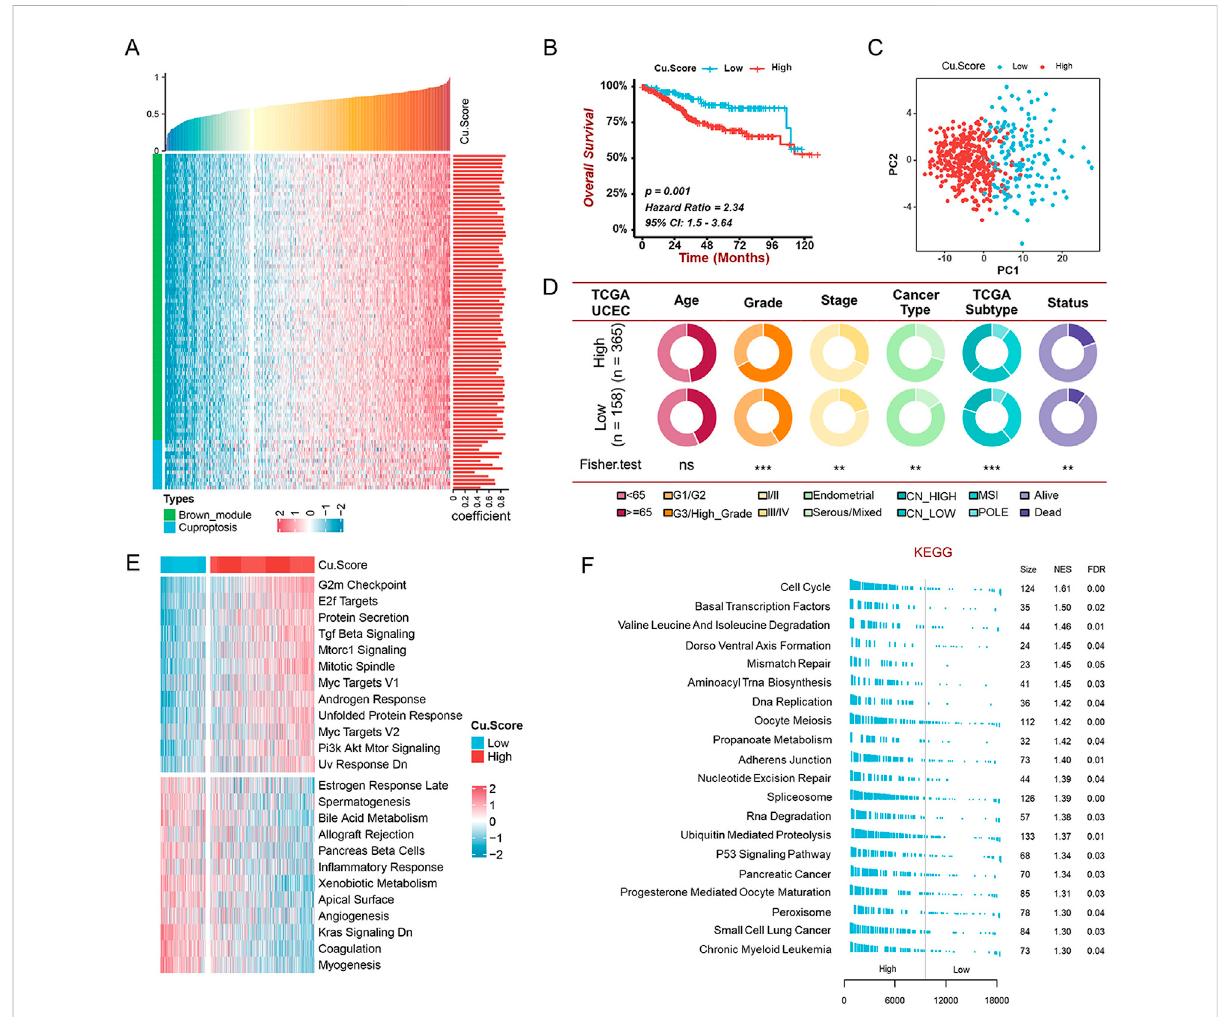
FIGURE 4 Construction of the Cu. Score and exploration of its clinical signi fi cance in the TCGA-UCEC cohort (A) The correlation analysis of the relationshipbetweencuproptosis-relatedgenesandCu.Score.Barchartontherightindicatesthedegreeofcorrelation. (B) TheKaplan-Meiercurve of signi fi cant difference in the survival rate between high- and low-Cu. Score groups in TCGA-UCEC cohort. (C) The PCA revealing the difference betweenthehigh-andlow-Cu.Scoregroups. (D) ThepiechartsshowingtheChi-squaredtestofclinicopathologicalcharactersbetweenhigh- and low-Cu. Score groups. (E-F) GSVA (E) and GSEA (F) showing the status of biological pathways between high- and low-Cu. Score